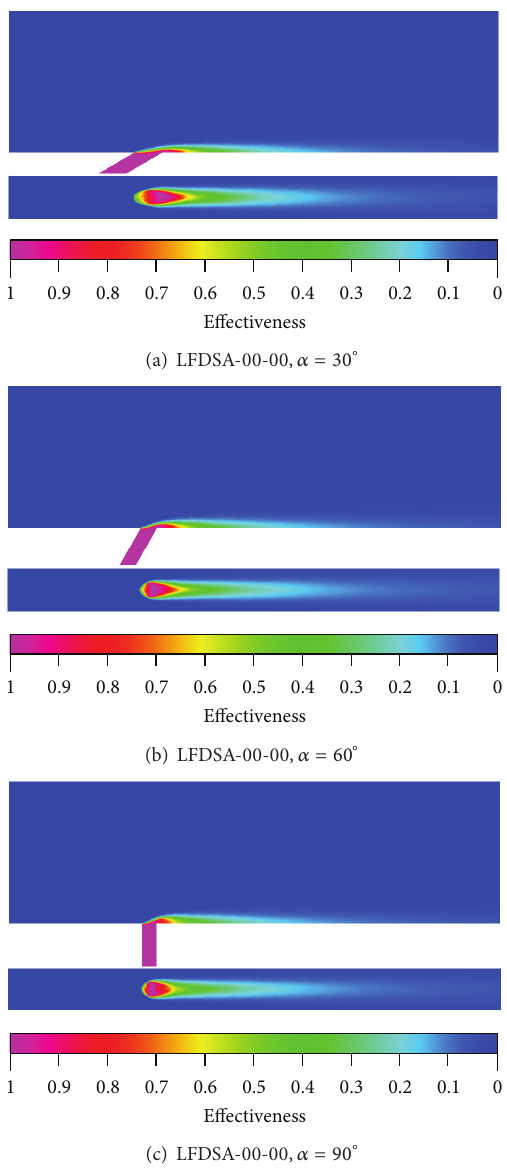
Figure 25: Top and symmetric planes effectiveness of LFDSA-00-00 for different streamwise angles and 𝑀 = 0.45